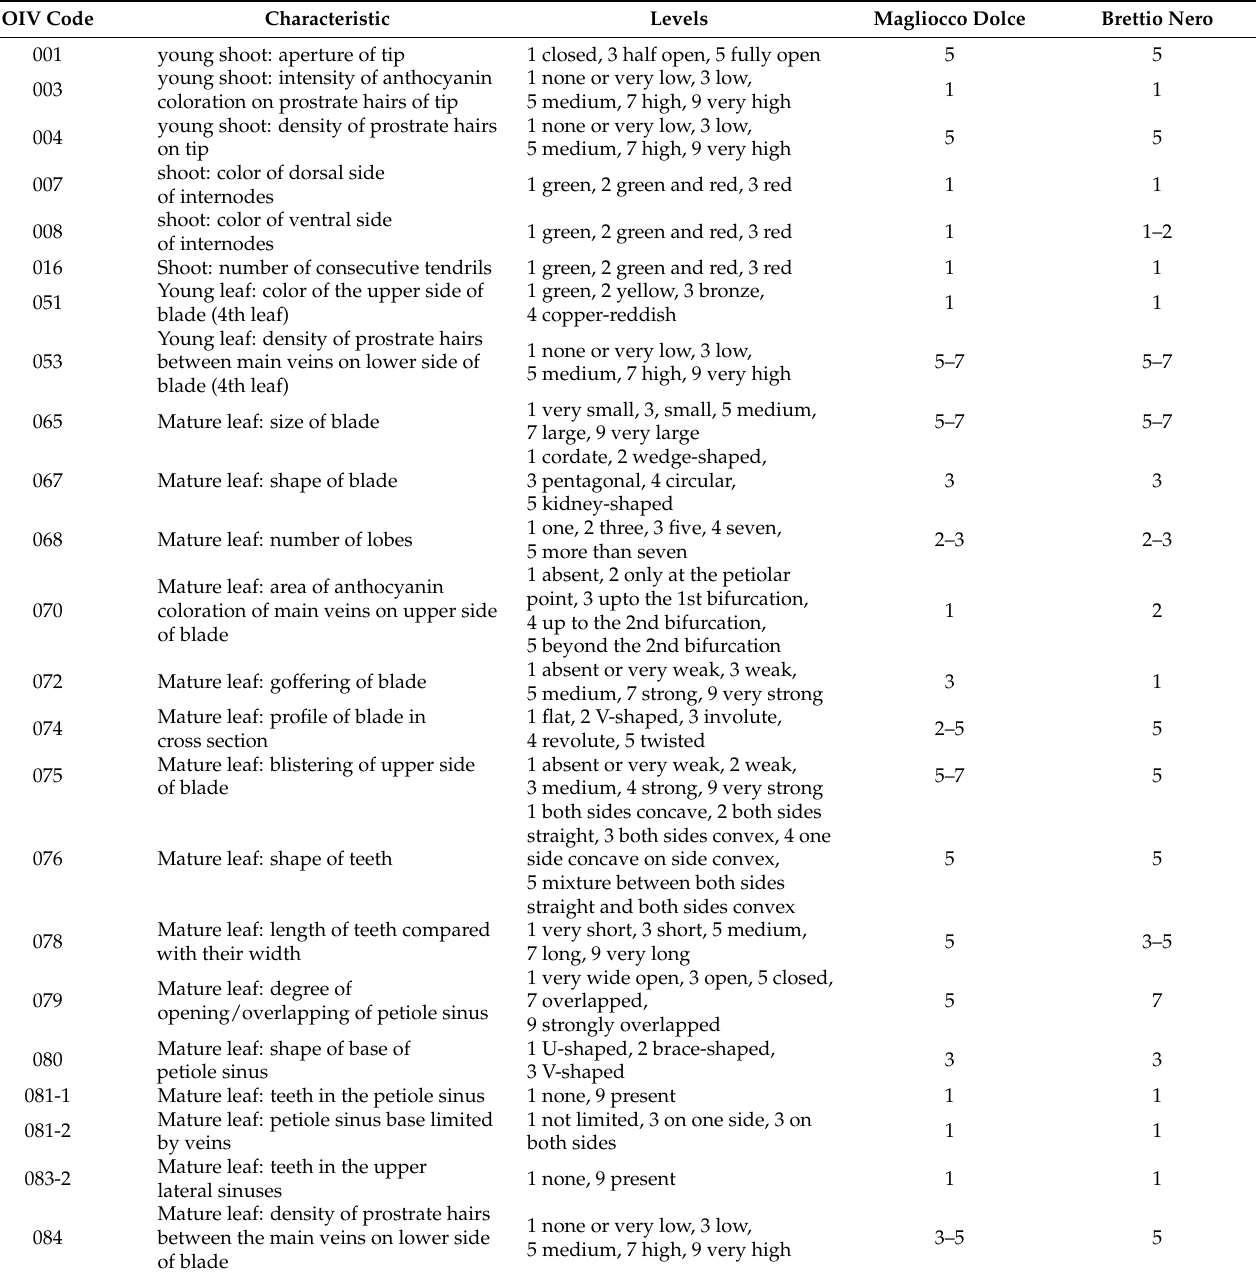
Table 3. Phenotypic profile of Magliocco Dolce and Brettio Nero accessions based on 45 OIV descriptors. OIV